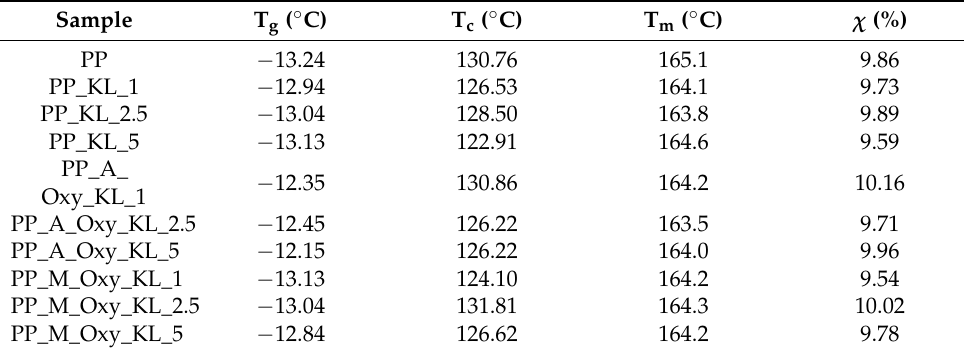
Table 3. Peak temperatures ( ◦ C) of the main thermal events observed during the cooling and second heating scan. The final column shows the crystallinity degree ( χ %), obtained from the melting peak of the second heating